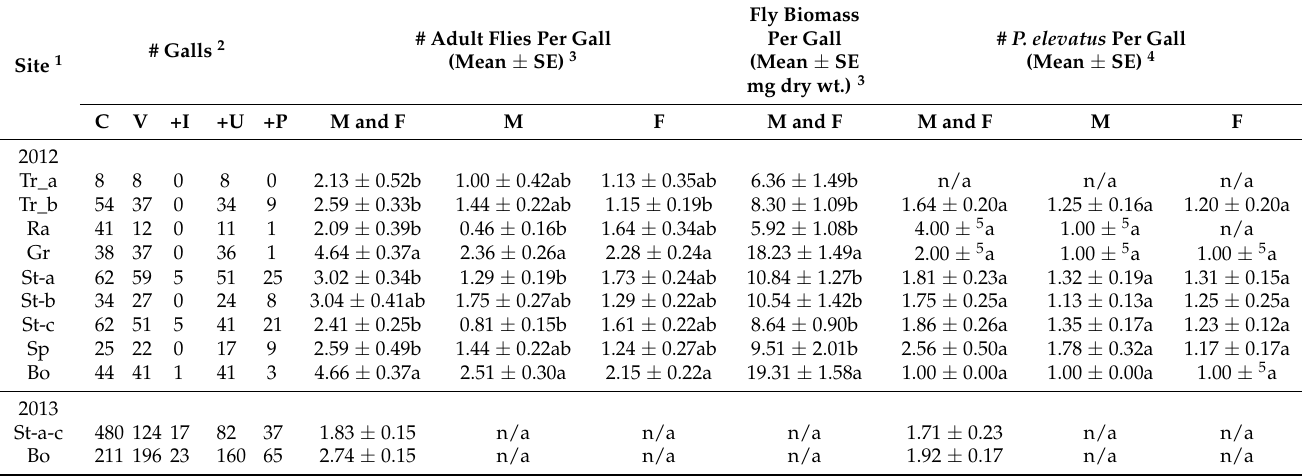
for males ( n = 31) and 3.4 ± 0.2 mg for females ( n = 46). Table 2. Data on insects associated with galls collected in 2012 and